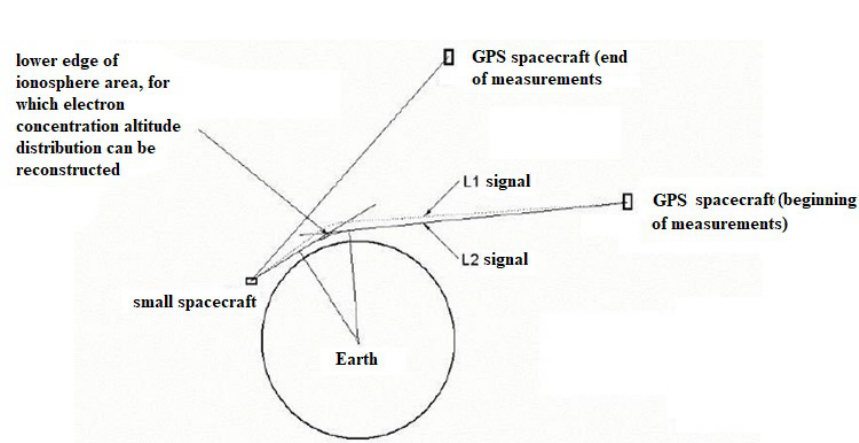
Fig. 2. The scheme of radio occultation measurements, on which there are presented the mutual position of low orbital small spacecraft and satellite of GPS navigation